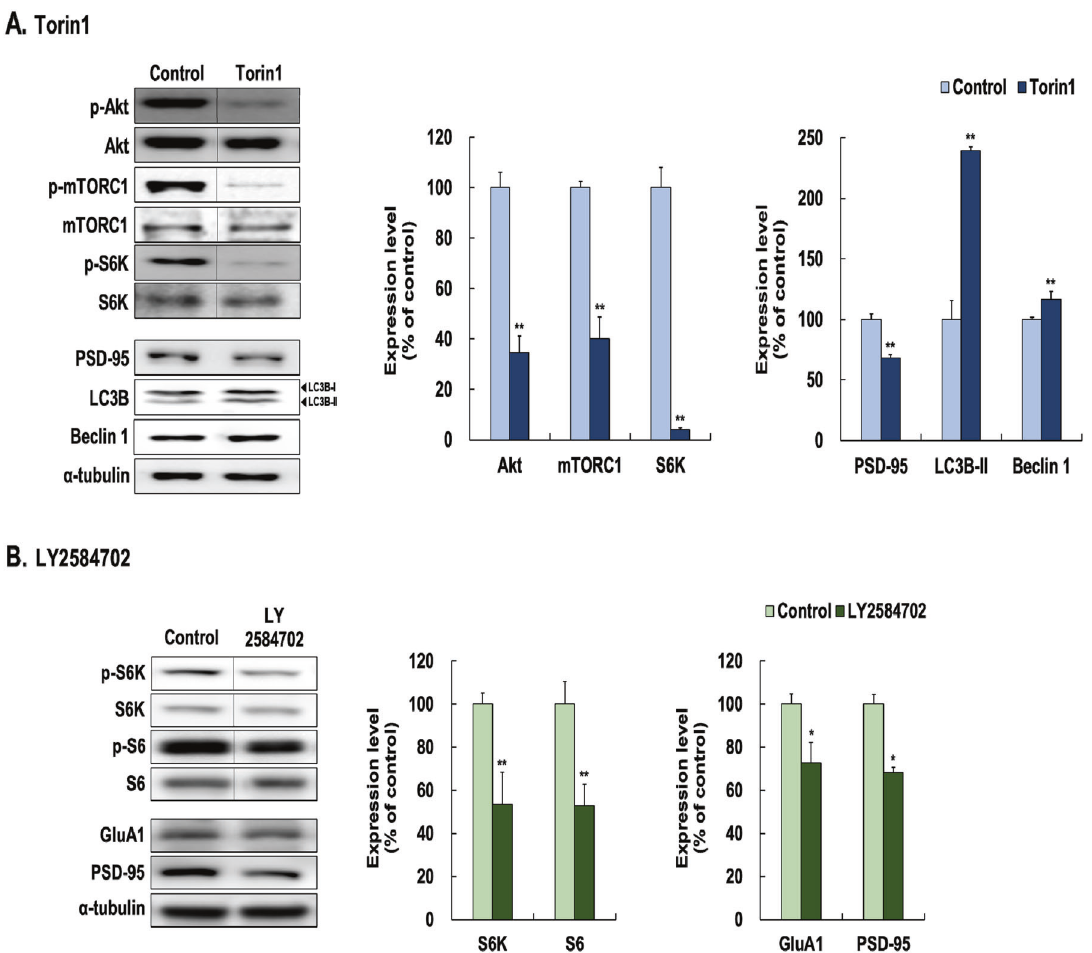
Fig. 3 Effects of Torin1 and LY2584702 in primary neuronal cells. Neuronal cells were treated with Torin1 ( A ) and LY2584702 ( B ) for 24 h at 250 nM concentration. Cell lysates were analysed by SDS-PAGE and Western blot analyses with each of the primary antibodies. Western blot analyses revealed the levels of phospho-Ser473-Akt, phospho-Ser2448-mTORC1, phospho-Thr389-S6K, phospho-Ser240/244-S6, PSD-95, GluA1, LC3B-II, and Beclin 1.Representative images and quantitative analyses normalized to the total levels for each protein or α -tubulin are shown. The original images for crude blot are shown in Supplementary Fig. 4 (Torin1) and in Supplementary Fig. 6 (LY2584702). Values ( n = 4 – 6) are shown as the mean ± SEM expressed as a percentage of the control cells (no drug) values. * p < 0.05, ** p < 0.01, unpaired Student t test